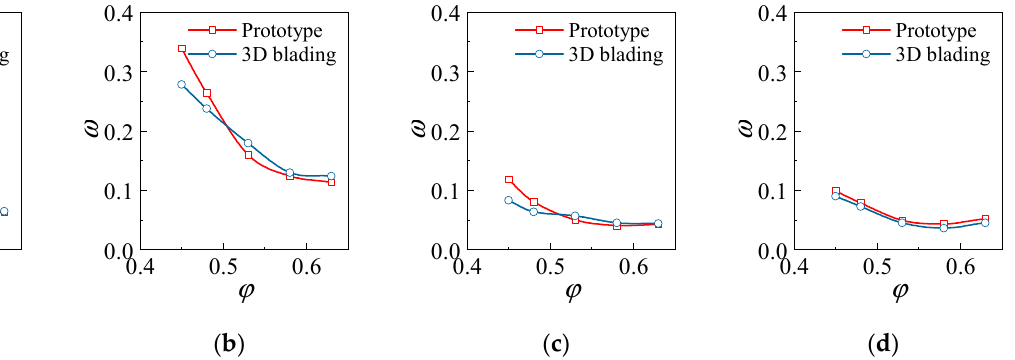
Figure 32. Comparison of loss characteristics of the cantilevered stator: ( a ) total loss, ( b ) hub loss, ( c ) midspan loss, and ( d ) tip loss.